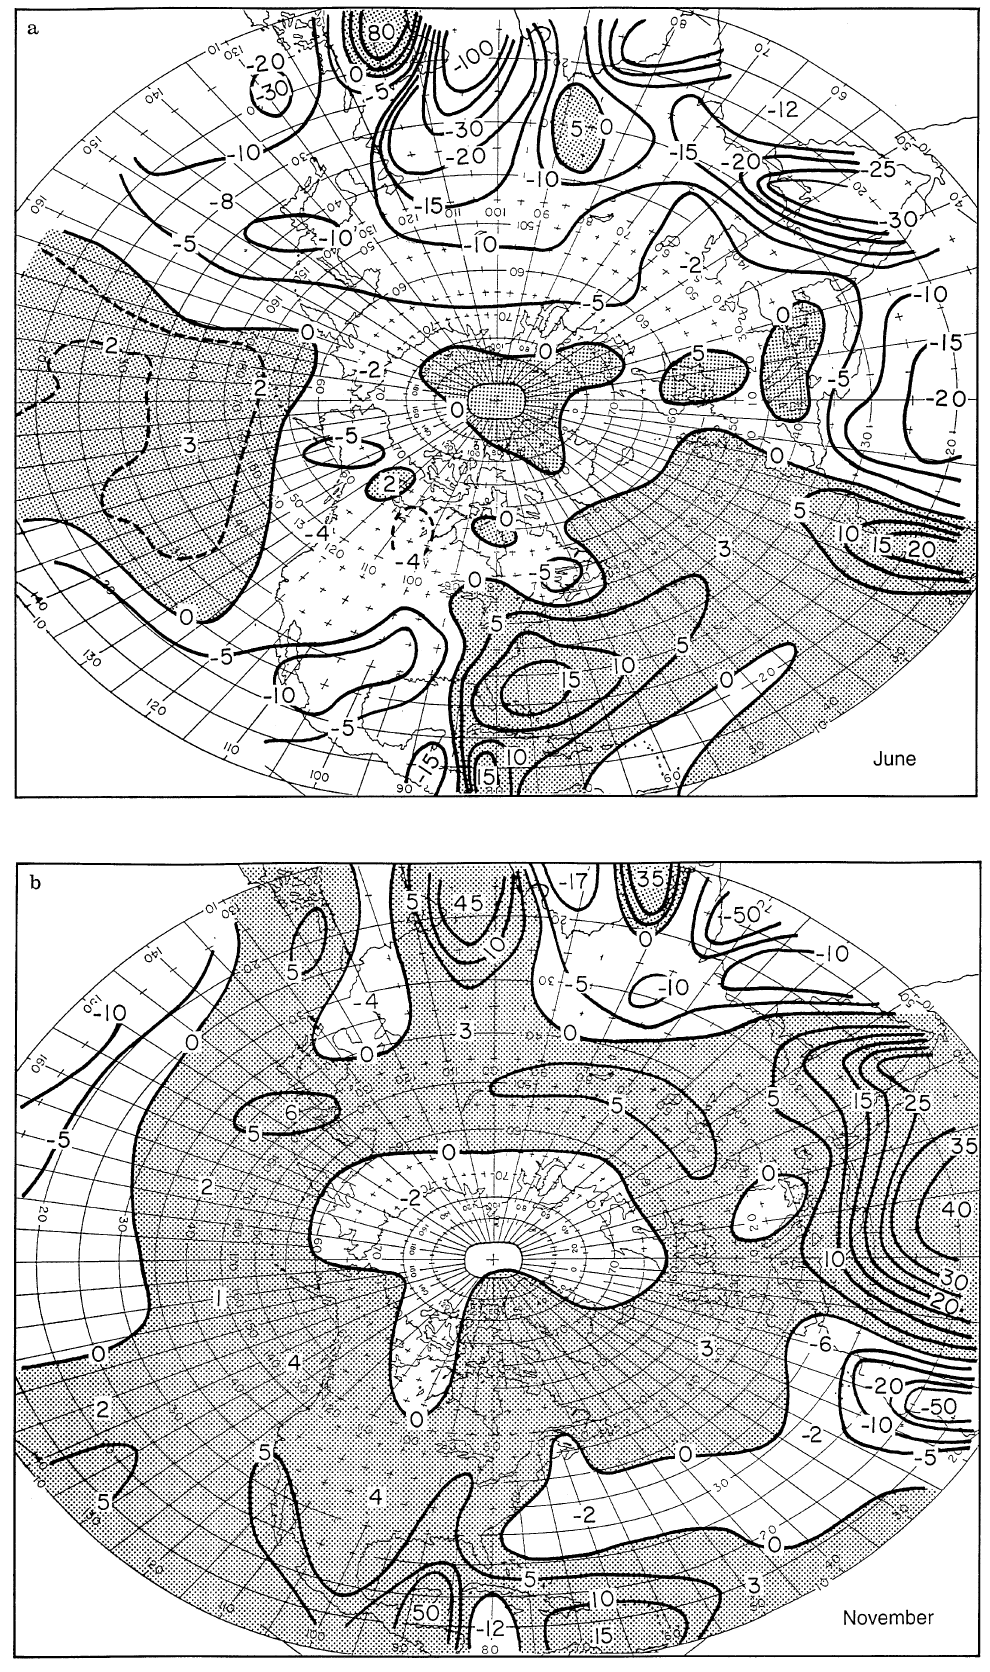
Fig. 3a, b. Precipitation anomalies resulting from orbital variations, in mm per month, for 4 kyears AP; a is for June, b